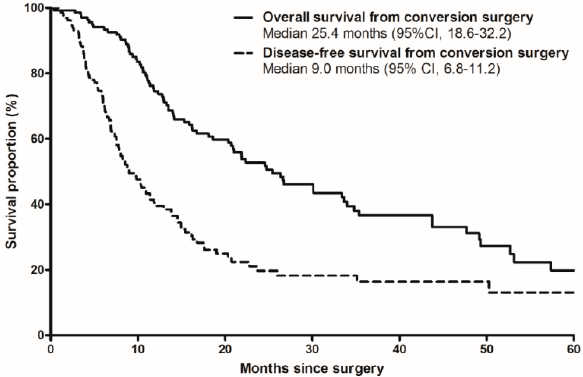
Figure 1. Overall survival (solid line) and disease-free survival (dotted line) from the time of surgery in patients with conversion surgery after neoadjuvant chemotherapy.